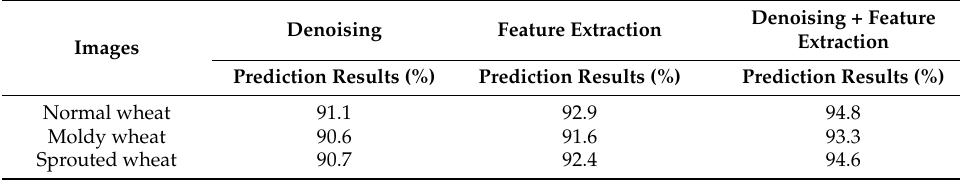
Table 3. A comparison of classification results.